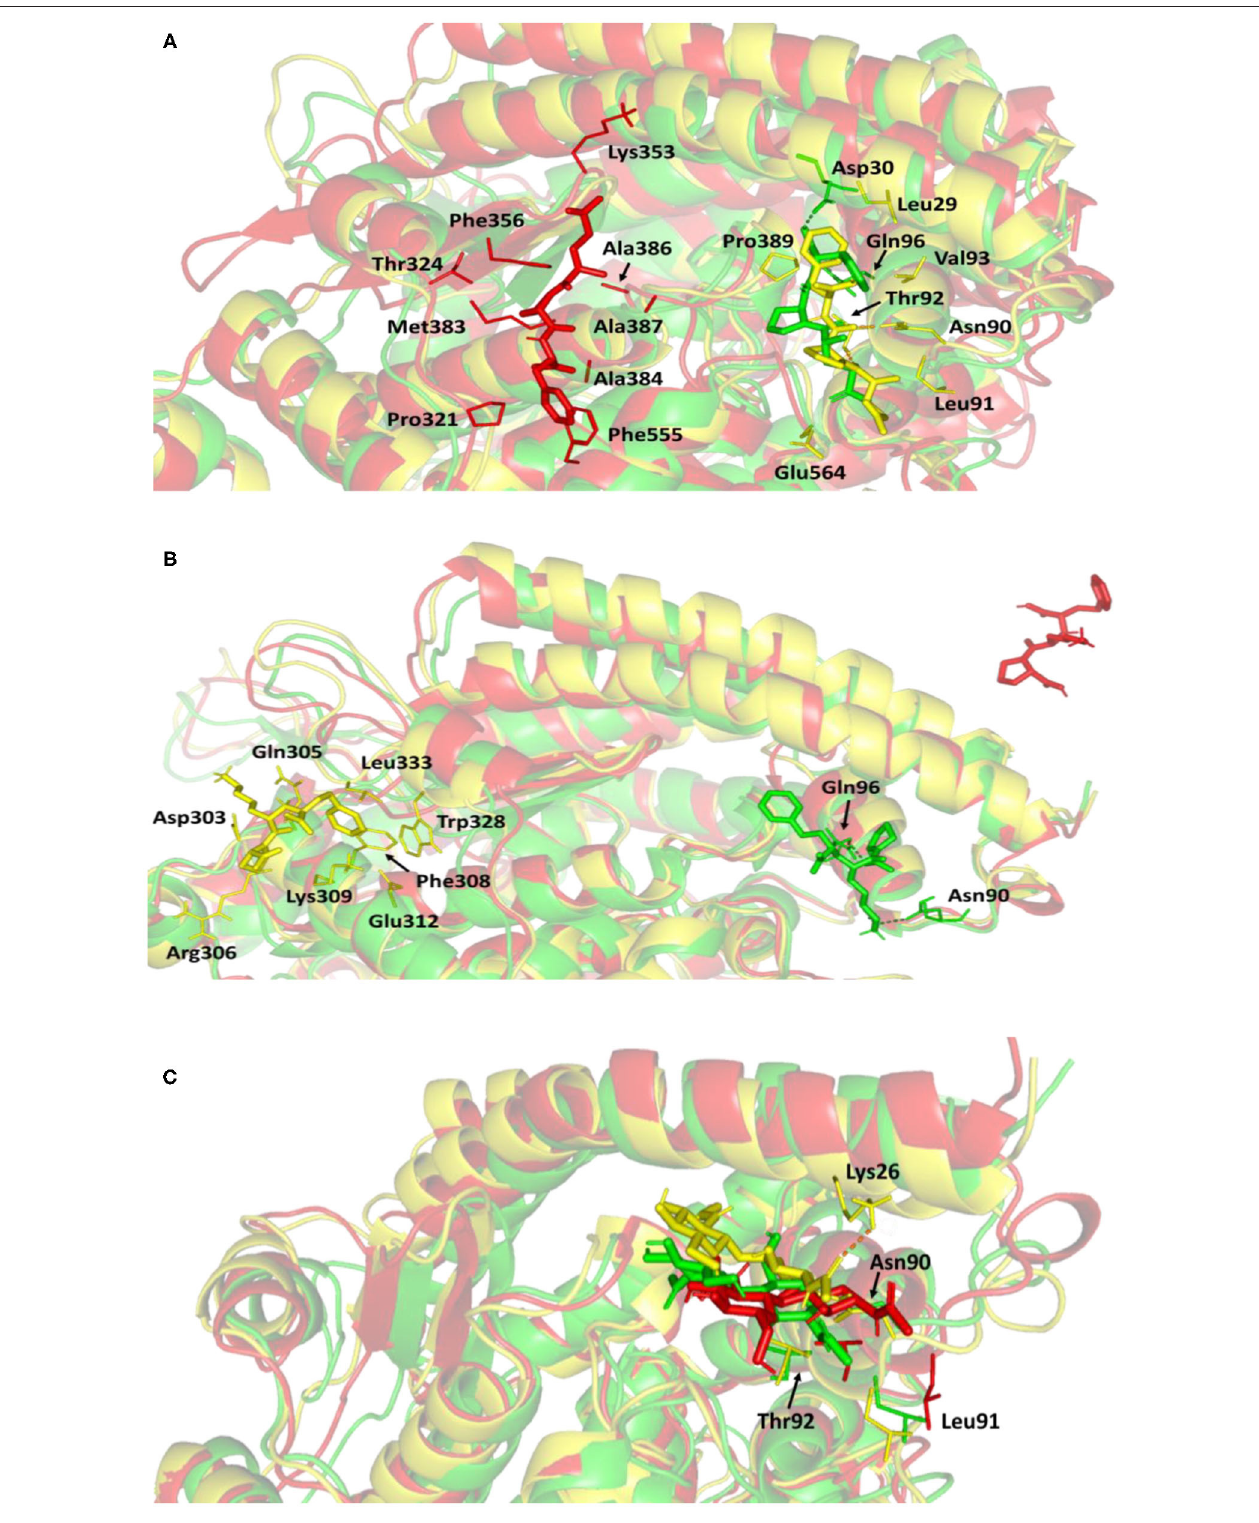
FIGURE 7 | Conformations of the ligand-protein complex at h ACE2 binding site through selected trajectories. (A) Alacepril; (B) lisinopril; (C) NAG. Protein is represented in green, yellow, and red cartoon 3D-representation corresponding to initial (0 ns), dynamic equilibrium (70 ns), and last (100 ns) extracted trajectories, respectively. The key binding residues (lines), ligands (sticks), and hydrophilic interactions (hydrogen bonding; dashed lines) are all presented in colors corresponding to their respective extracted trajectory.